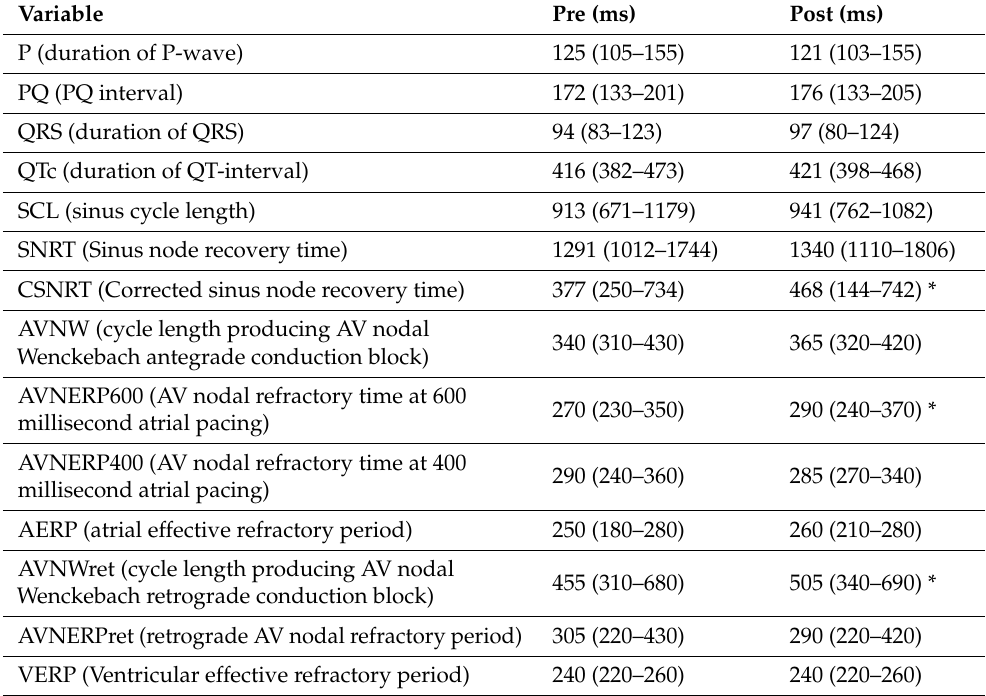
Table 4. Electrophysiological properties. Figures represent time in milliseconds (ms). Pre = baseline, Post = after DEX. Statistically significant difference between pre- and post-DEX measures is marked with * ( p <